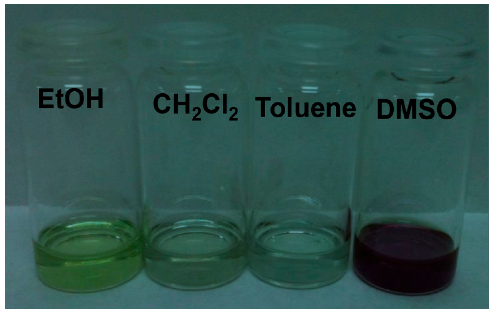
Figure 6. Solvatochromic effect of compound 84b . Reprinted with permission from ref.